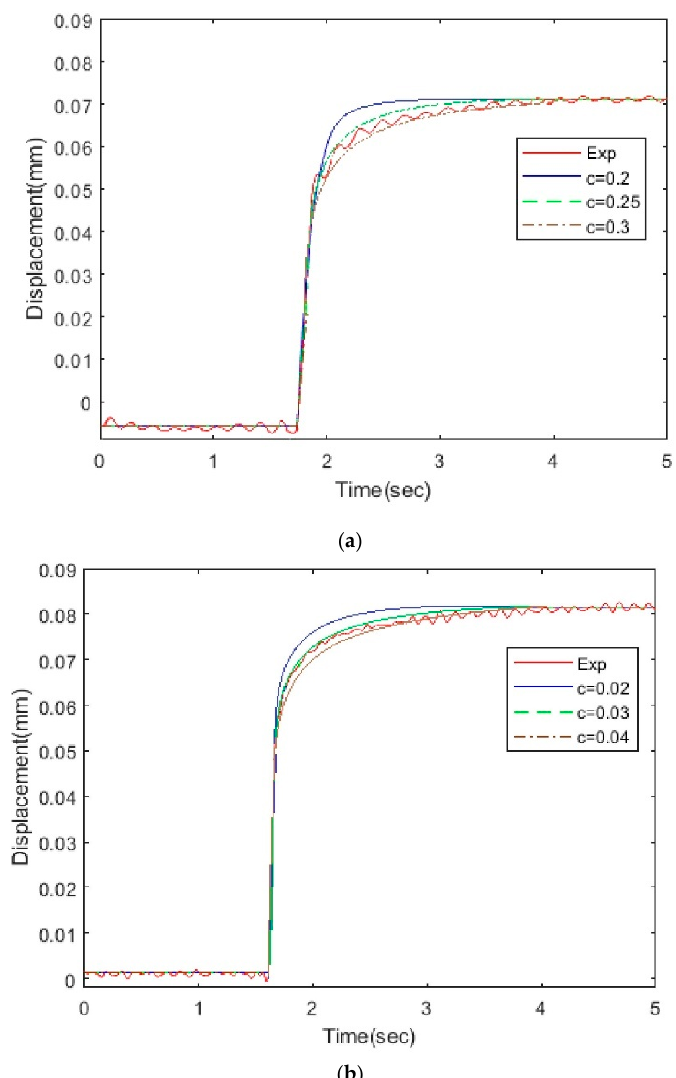
Figure 20. ( a ) Damping coefficient identification with VCA (conductive). ( b ) Damping coefficient identification with VCA (non-conductive).